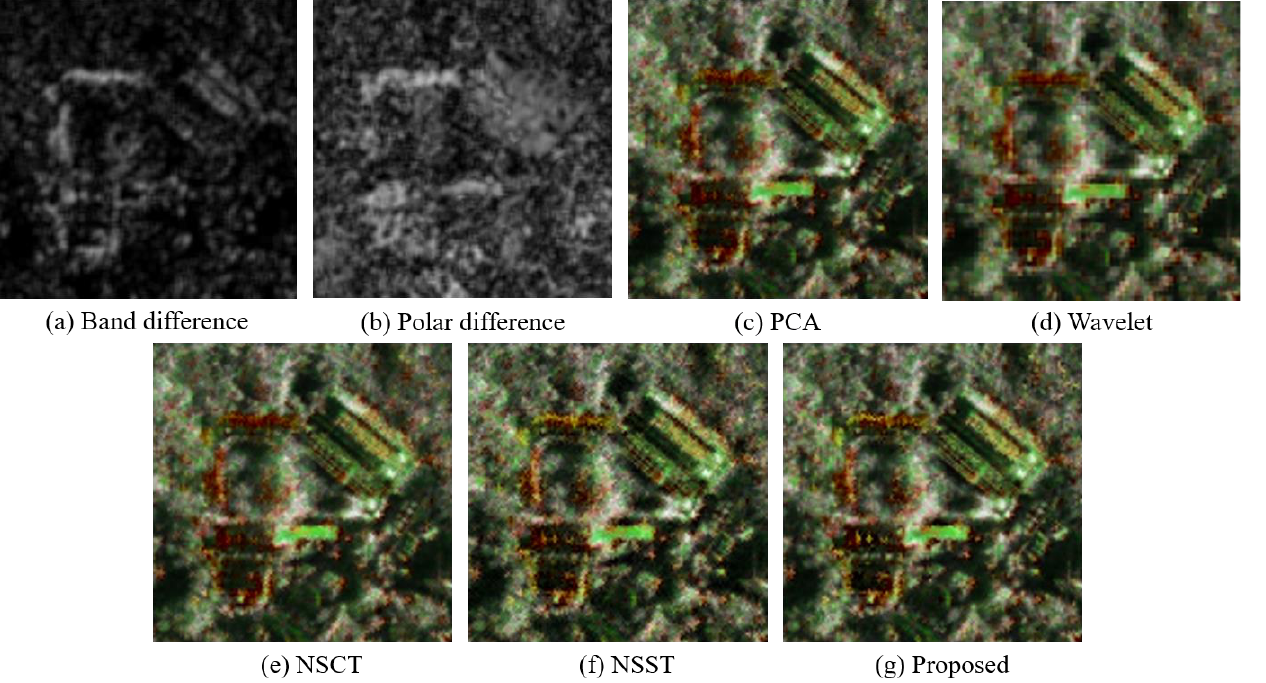
Figure 9. Band difference map, polarization difference map, and colorized fusion results of special region in scene 1: ( a ) Band difference map; ( b ) polarization difference map; ( c ) colorized PCA fusion; ( d ) colorized wavelet fusion; ( e ) colorized NSCT fusion; ( f ) colorized NSST fusion; and ( g ) colorized proposed method fusion.